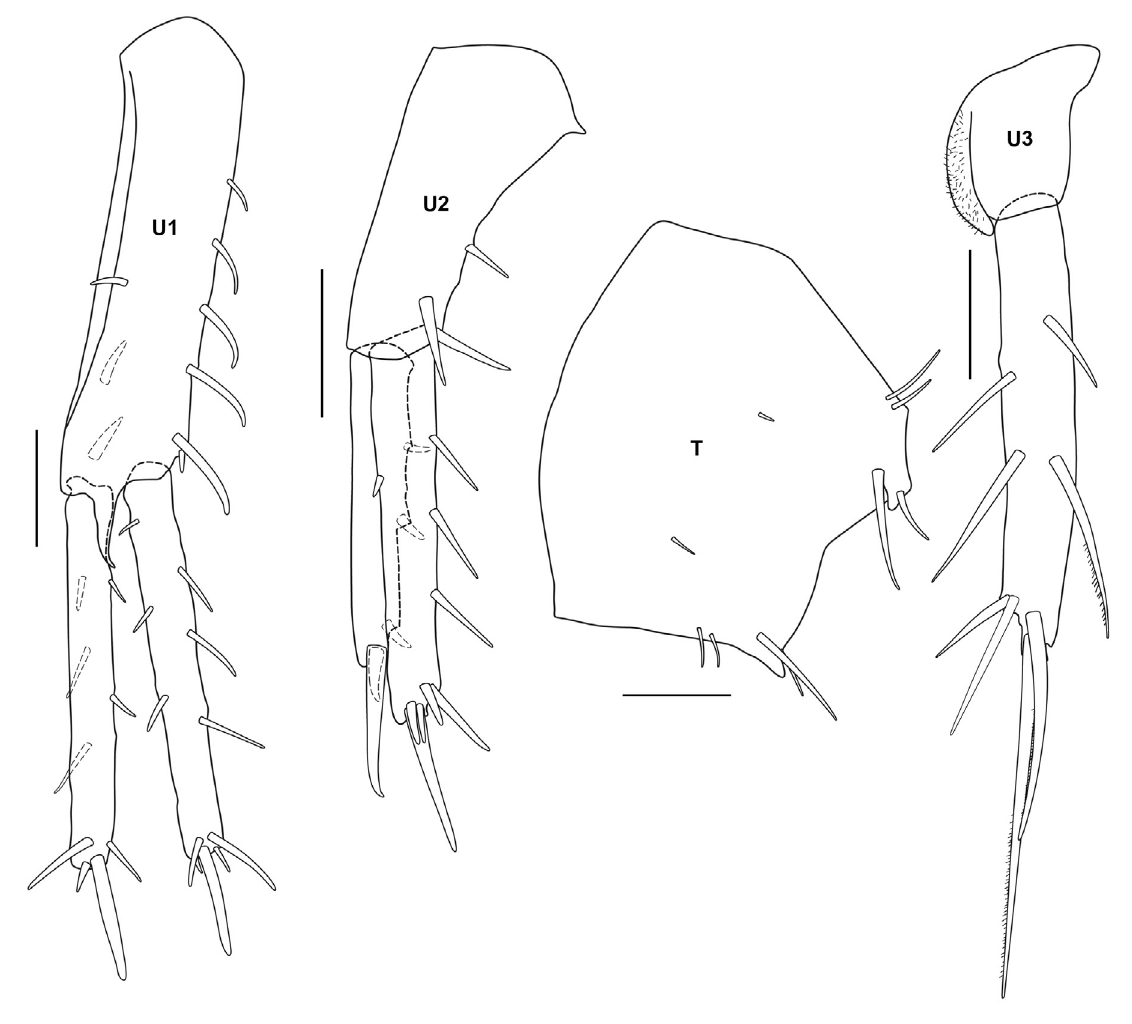
Fig. 10. Grandidierella pawaiensis sp. nov., allotype, ♀ (ZRC 2018.0494). Scale bars: U1–U2 = 0.1 mm; U3, T = 0.05